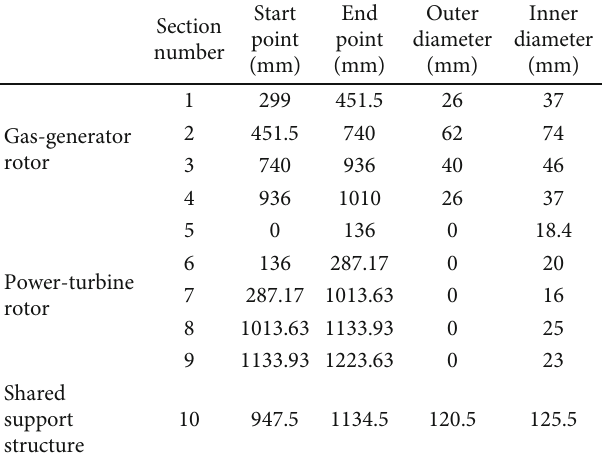
Table 3: Parameters of shafts.